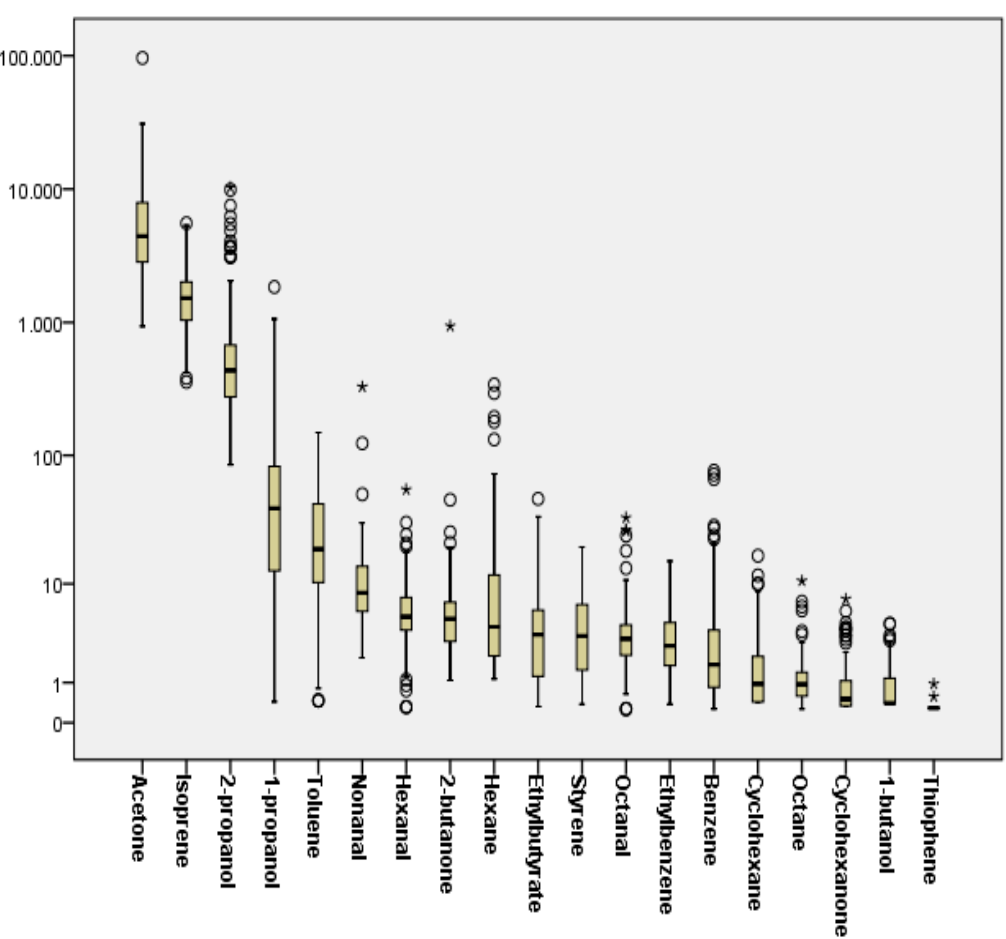
Figure 1. Median breath concentrations (ng/L air) in study participants. ο : outliers, *: extreme values